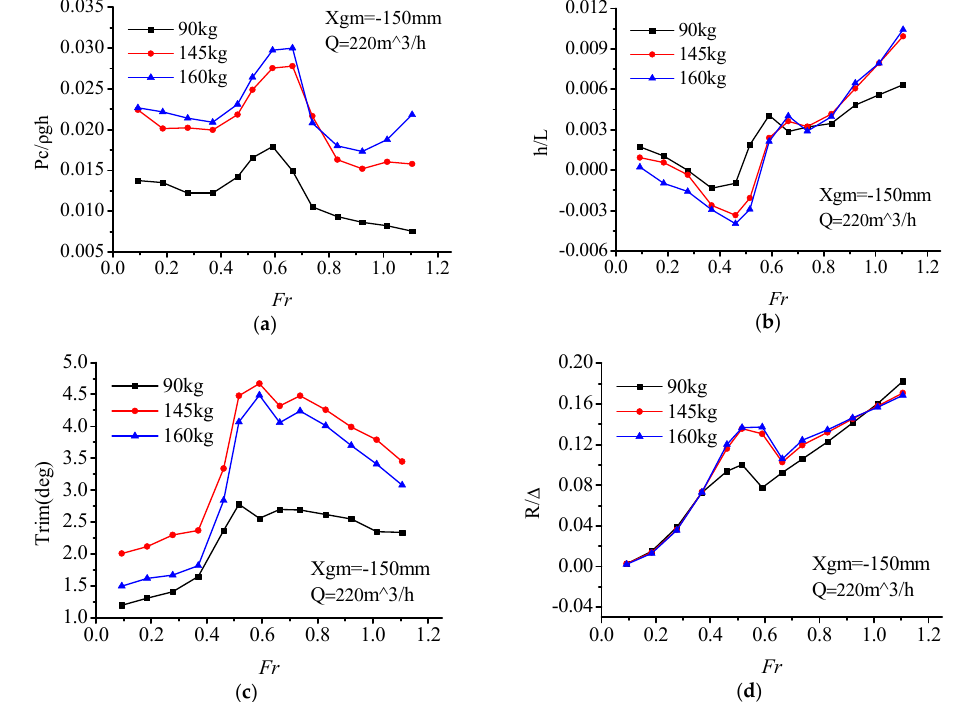
Figure A5. Comparisons of numerical and experimental results with consistent airflow Q = 220 m 3 /h. ( a ) Curves of air cushion pressure; ( b ) Curves of air cushion heave; ( c ) Curves of trim angle; ( d ) Curves of total resistance.